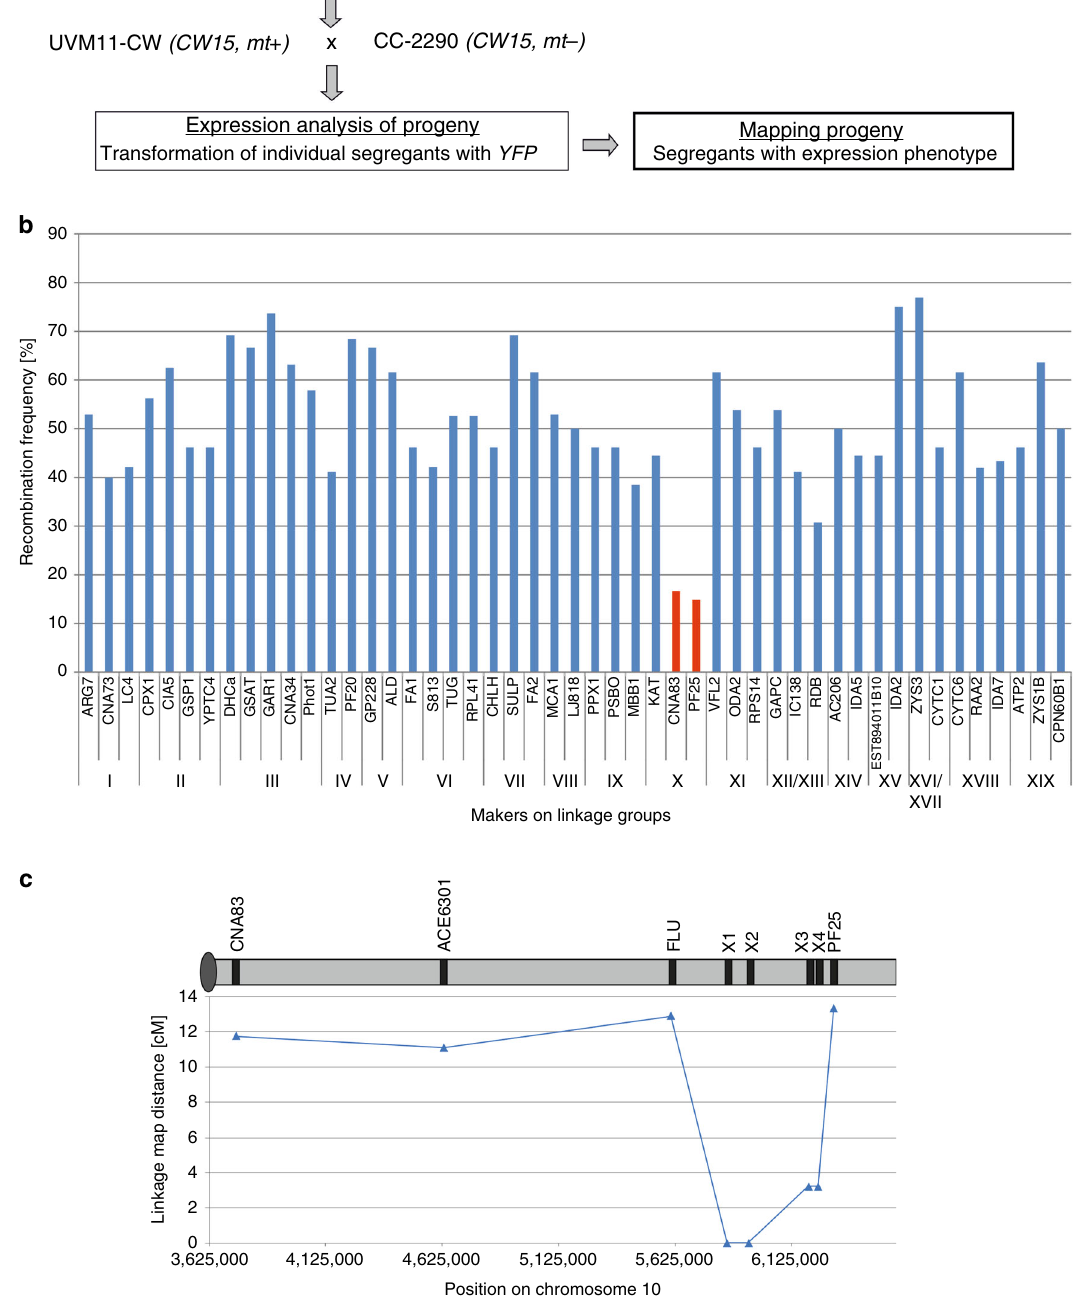
Fig. 2 Identi fi cation of the UVM gene. a Mapping strategy. The cell wall-de fi cient expression strain UVM11 was crossed to the wild-type strain CC-124 in order to reintroduce cilia (required for ef fi cient mating). Offspring (UVM11-CW) that showed similarly strong transgene expression capacity as the parental UVM11 strain was then crossed to the polymorphic strain CC-2290. The progeny of this cross was phenotyped for transgene expression ef fi ciency by transforming every segregant with the YFP reporter gene and analyzing on average 20 transformants per segregant. Offspring displaying high-level YFP expression was used as mapping population. b Marker analysis links the transgene expression phenotype to a locus on chromosome 10. The two markers showing low recombination frequency (<20%) are indicated in red. c Fine mapping of uvm on chromosome 10. The new markers X1, X2, X3, and X4 were derived from candidate genes that reside between markers CNA83 and PF25 and potentially have chromatin-related functions 36 (http://phytozome.jgi. phylogenetic sirtuin classes II and III, respectively, the Chlamydo- organisms revealed that SRTA is more closely related to the sirtuin- monas histone deacetylase SRTA falls into class IV, a class that does type HDAC from Arabidopsis and humans than to SRTB and SRTC not contain prokaryotic members (Fig. 3c; ref. 26 ). Class IV includes (Fig. 3c). In contrast to the Chlamydomonas histone deacetylases SRTB and SRTC, which group with the sequence-related the human sirtuins SIRT6 and SIRT7 that are both nucleus-